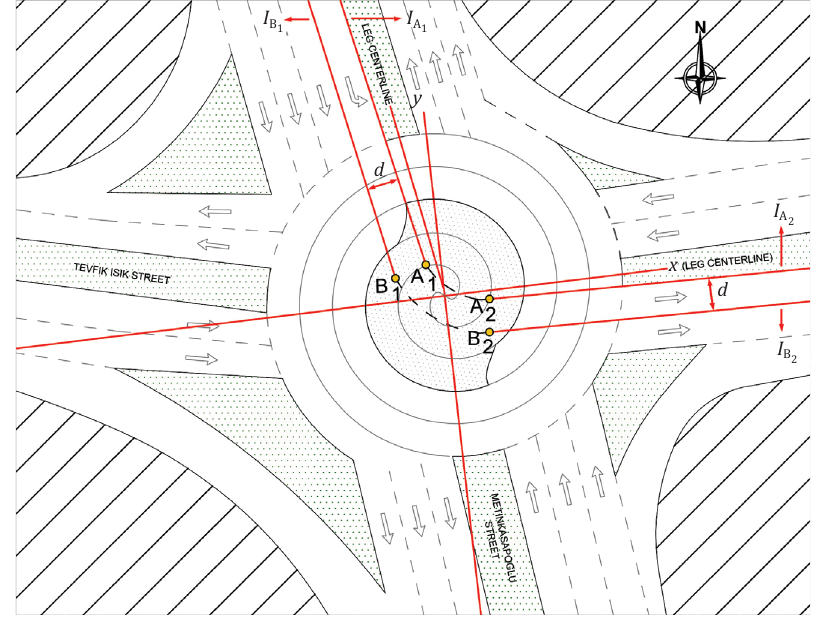
Figure 7b. Illustrative roundabout (by G.